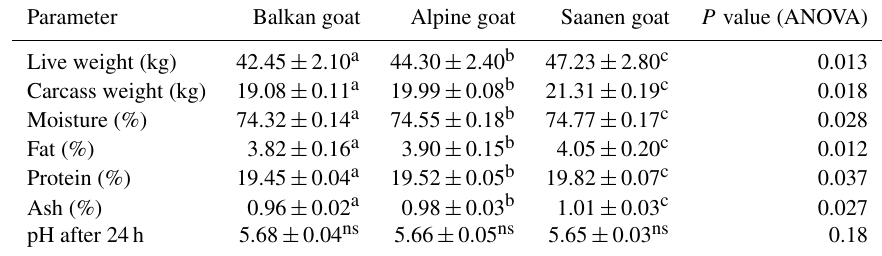
Table 1. Goat live weight and m. gluteus superficialis proximal composition and pH ( n = 40 per breed). Parameter Balkan goat Alpine goat Saanen goat